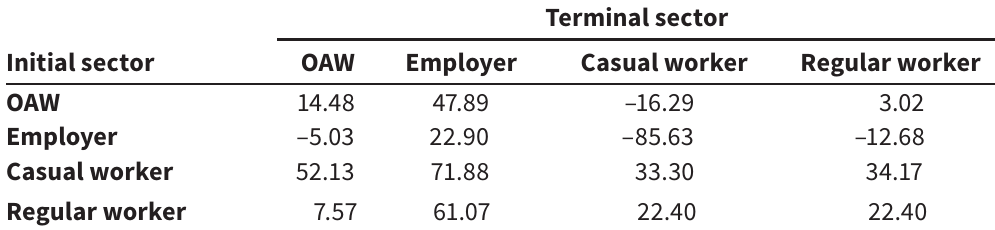
Mobility and earnings change